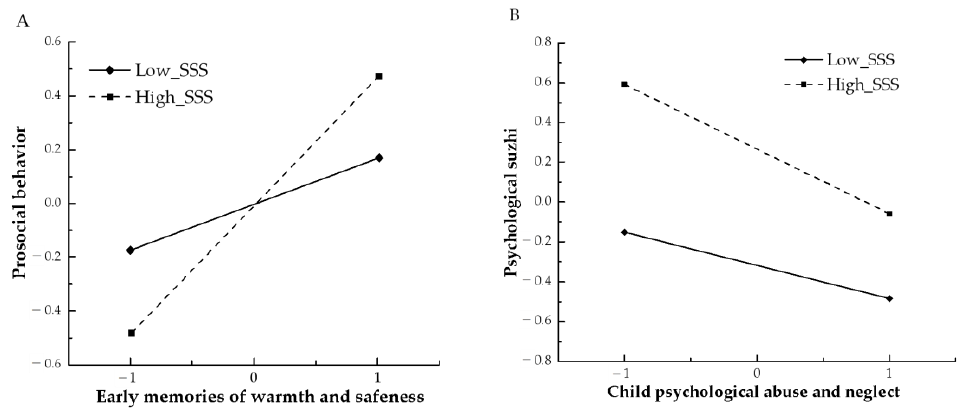
Figure 4. ( A ) SSS as a moderator in the effects of EMWS on prosocial behavior; ( B ) SSS as a moderator in the effects of CPAN on psychological suzhi .